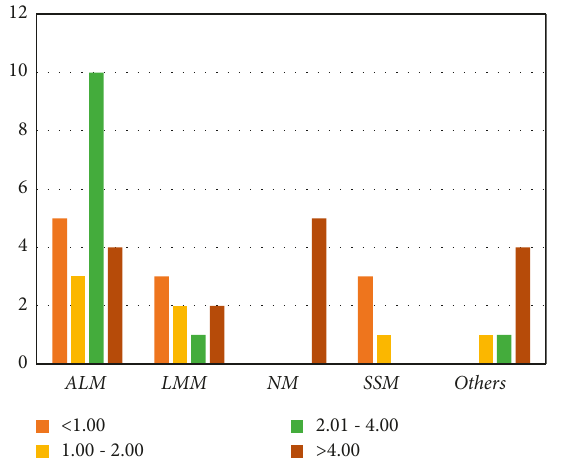
Figure 3: Breslow thickness in different types of melanoma.